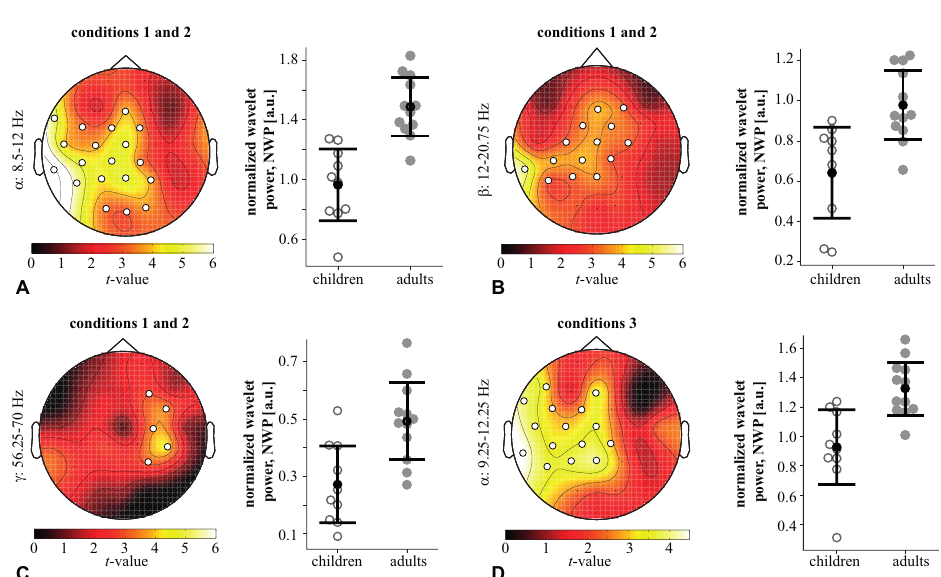
Figure 5. ( A – D ) Significant clusters reflect the difference between the adults’ NWP and children’s NWP in the α -, β -, and γ -bands for conditions1,2 , and in the α -band for condition3 . Topograms illustrate t -values. The NWP in these clusters is also shown as the mean ± SD and individual scores for children and